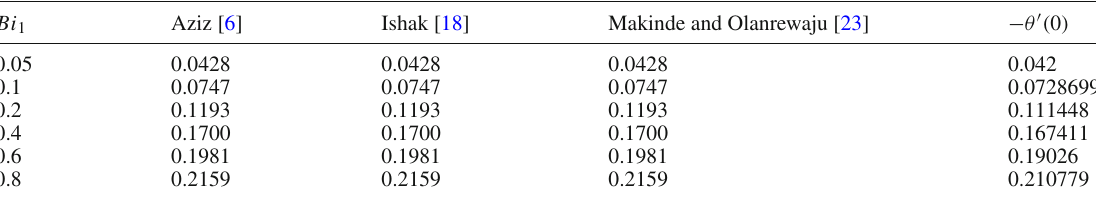
Table 3 Comparison with Aziz [6], Ishak [18] and Makinde & Olanrewaju [23] for (incompressible fluid) -3b8’(0) when Pr = 0.72 Bi